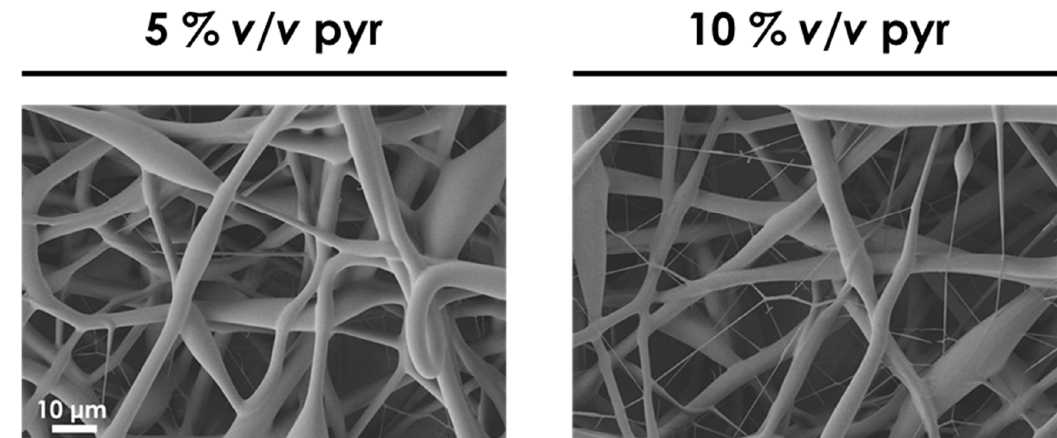
Figure 3. SEM images of 20% w/v PCLGA in chloroform with 5% v/v and 10% v/v of pyridine. 2 mL/h, 15 kV and 20 cm. Both images share the same scale bar: 10 μ m.